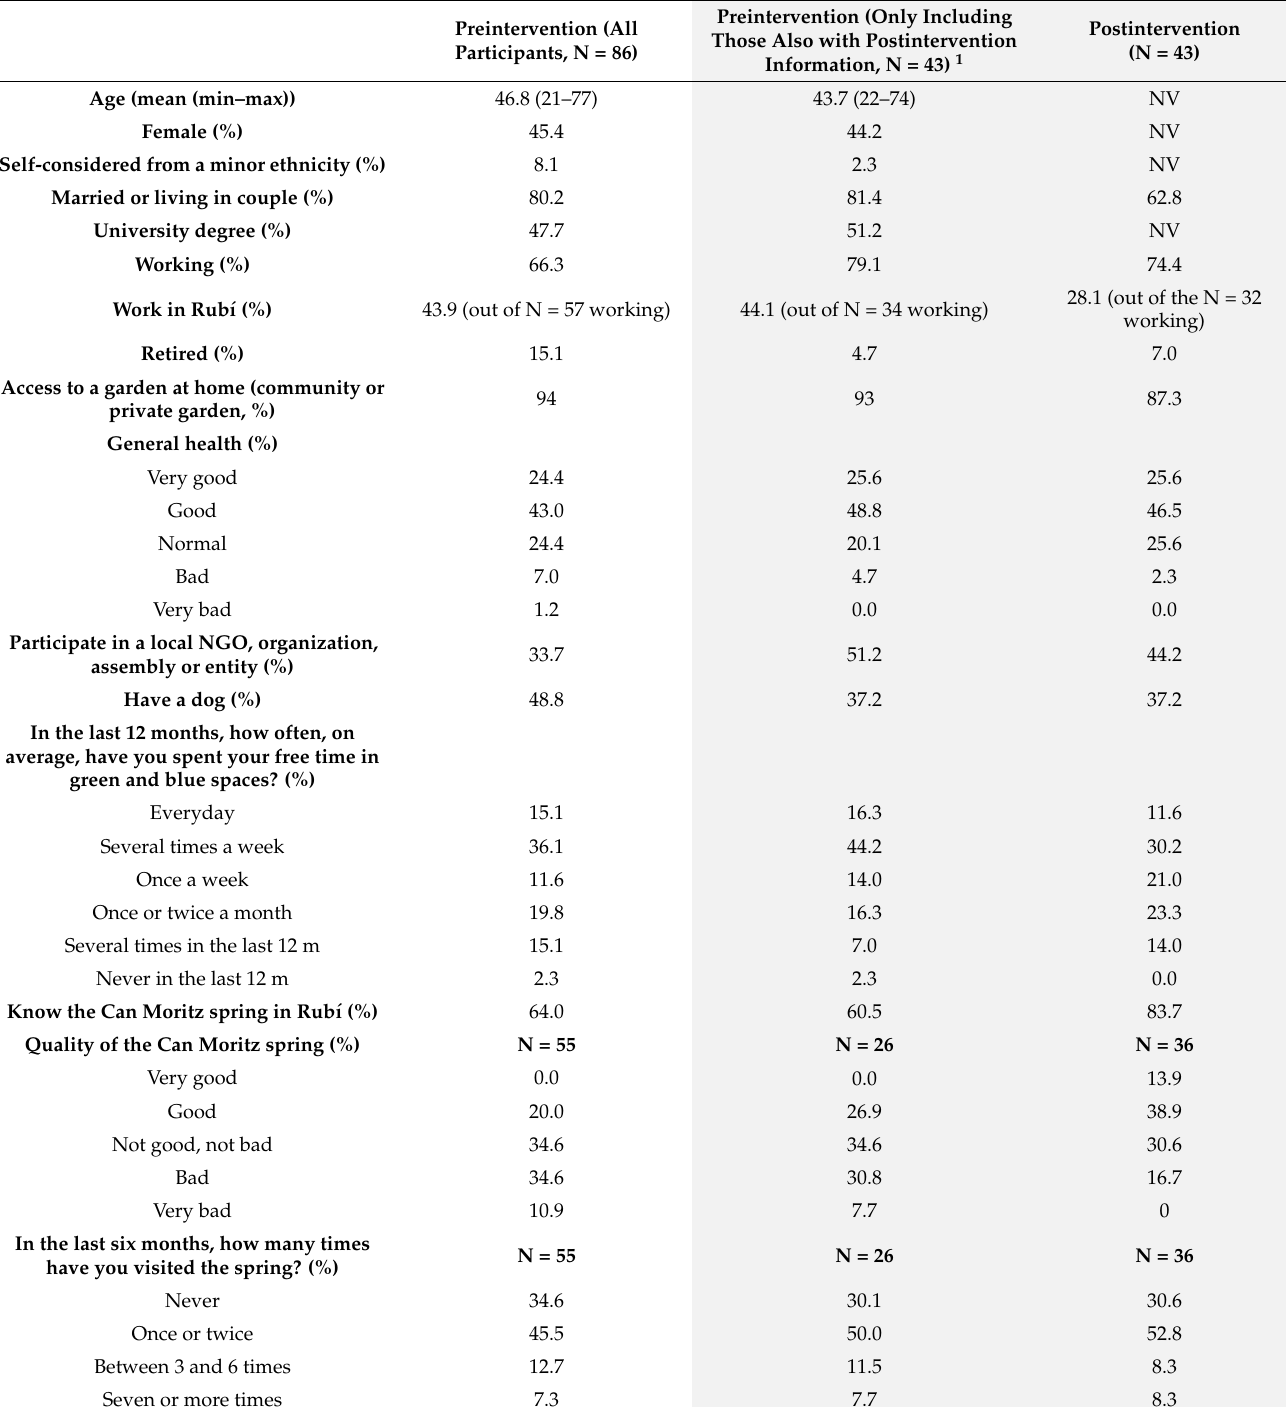
Table 1. Descriptive table of the survey